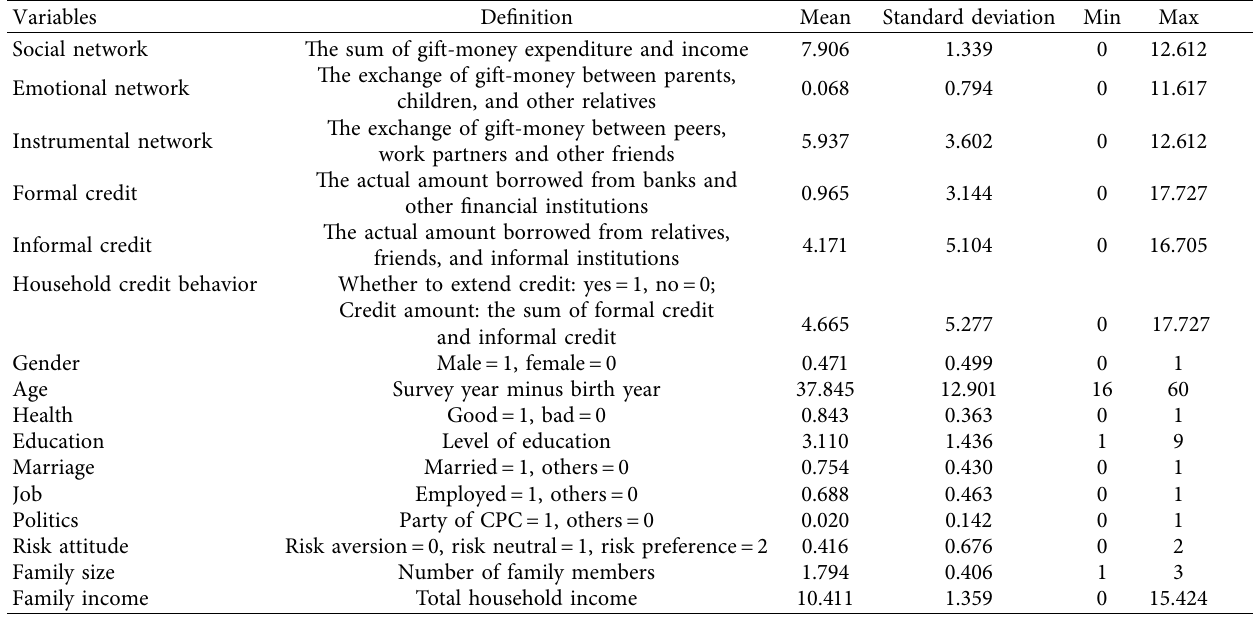
Table 2: Definition of variables and descriptive statistics.